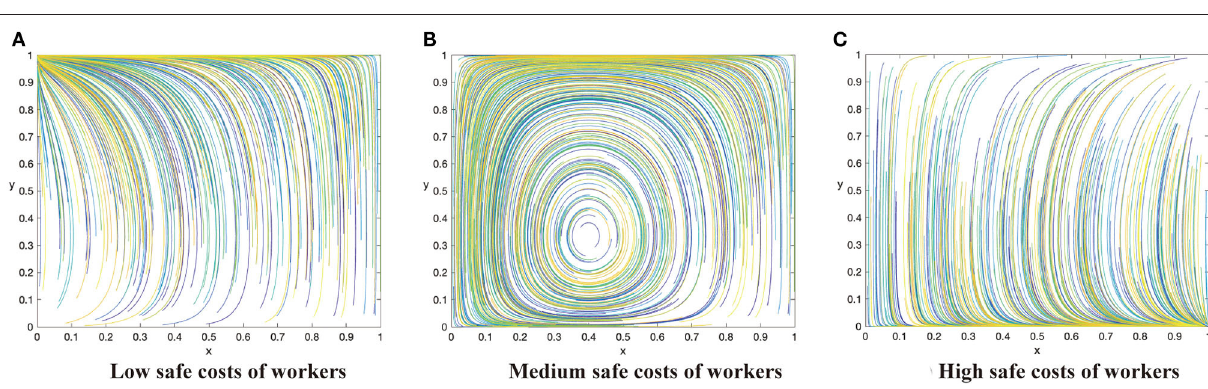
relatively low. In the two sub-categories above ( Figures 1A,B ), cost of workers is less than β ( p